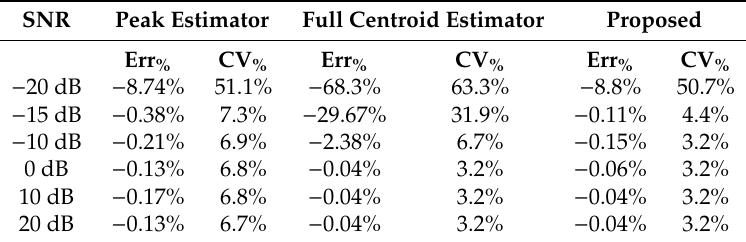
Table 1. Accuracy and